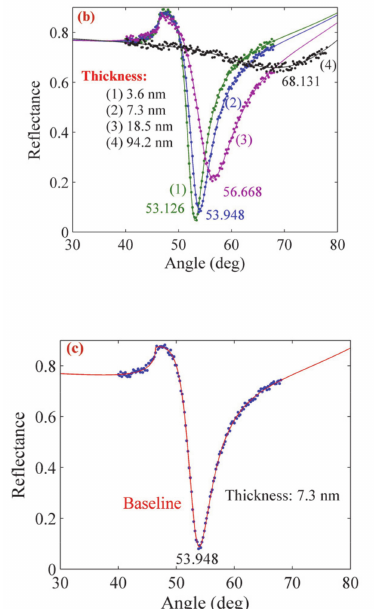
Figure 3. ( a ) Variation in the thickness of layer with increasing the cycle; ( b ) The SPR signal related to obtaining the refractive index of the PPy–Chi–BaFe 2 O 4 composite layer in the di ff erent thickness; ( c ) The SPR signal at the baseline.